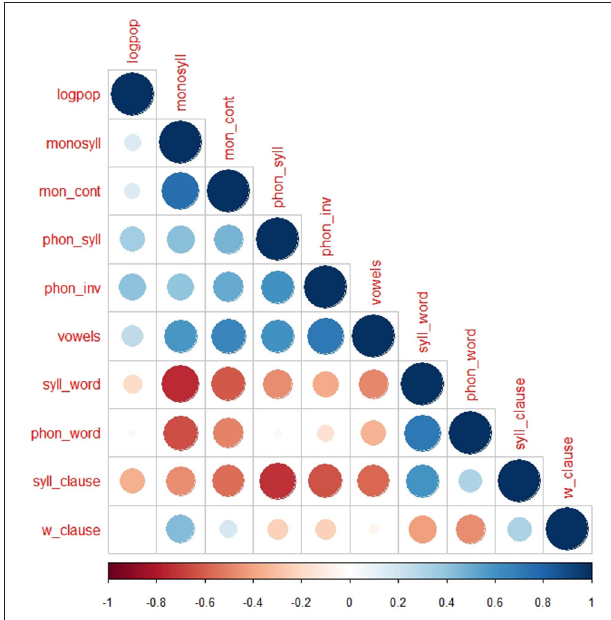
FIGURE 2 | Correlation matrix between the linguistic variables and log of population